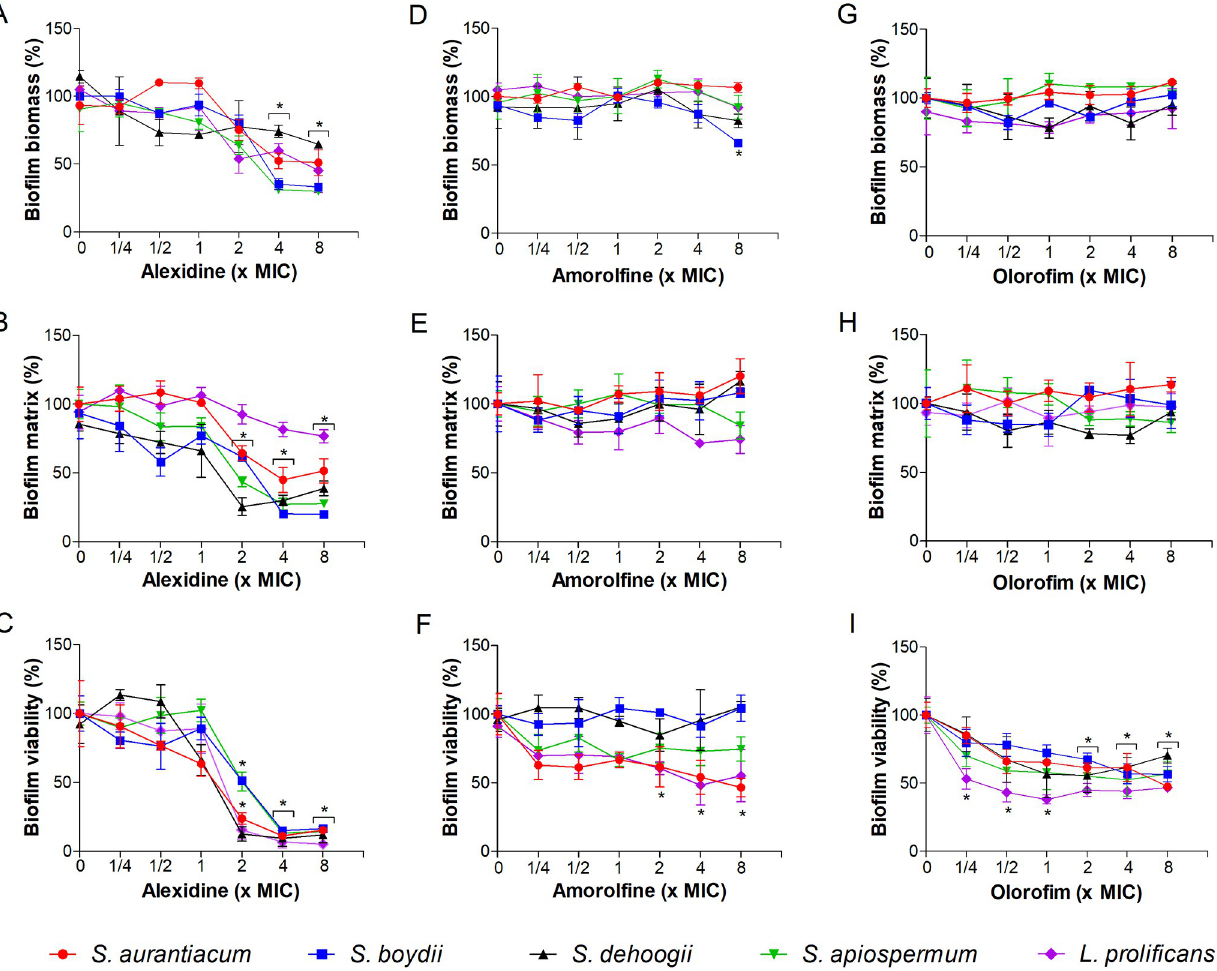
Fig 4. Effect of alexidine, amorolfine and olorofim on preformed biofilms of Scedosporium and Lomentospora species. Fungal biofilm was obtained in RPMI 1640 medium for 24 h and then treated with different concentrations of alexidine, amorolfine or olorofim for an additional 24 h incubation. Fungal biomass (A, D and G), extracellular matrix (B, E and H) and viability (C, F and I) were measured using crystal violet and safranin stains, and XTT- reduction assay, respectively. � p < 0.01, compared to zero (absence of drug) for each species. Experiments were performed in triplicate, in three independent experimental